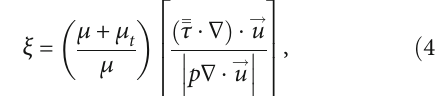
Table 6: Dissipation components for C